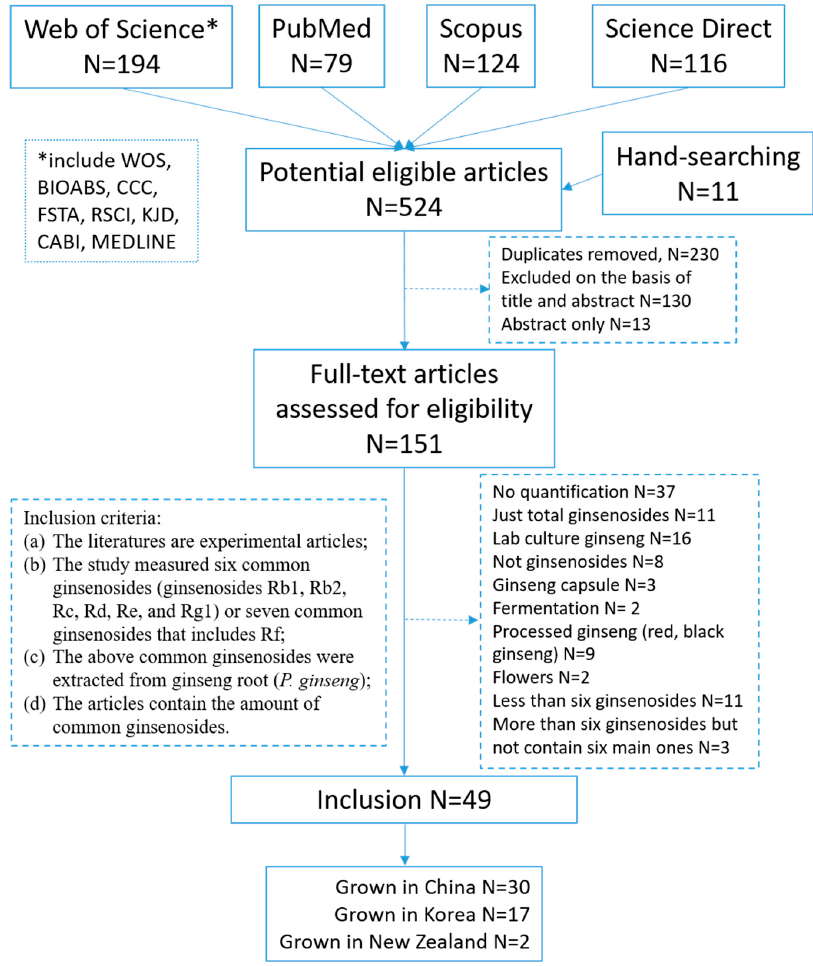
Figure 2 . Flow diagram of study search and inclusion criteria . Figure 2. Flow diagram of study search and inclusion criteria.